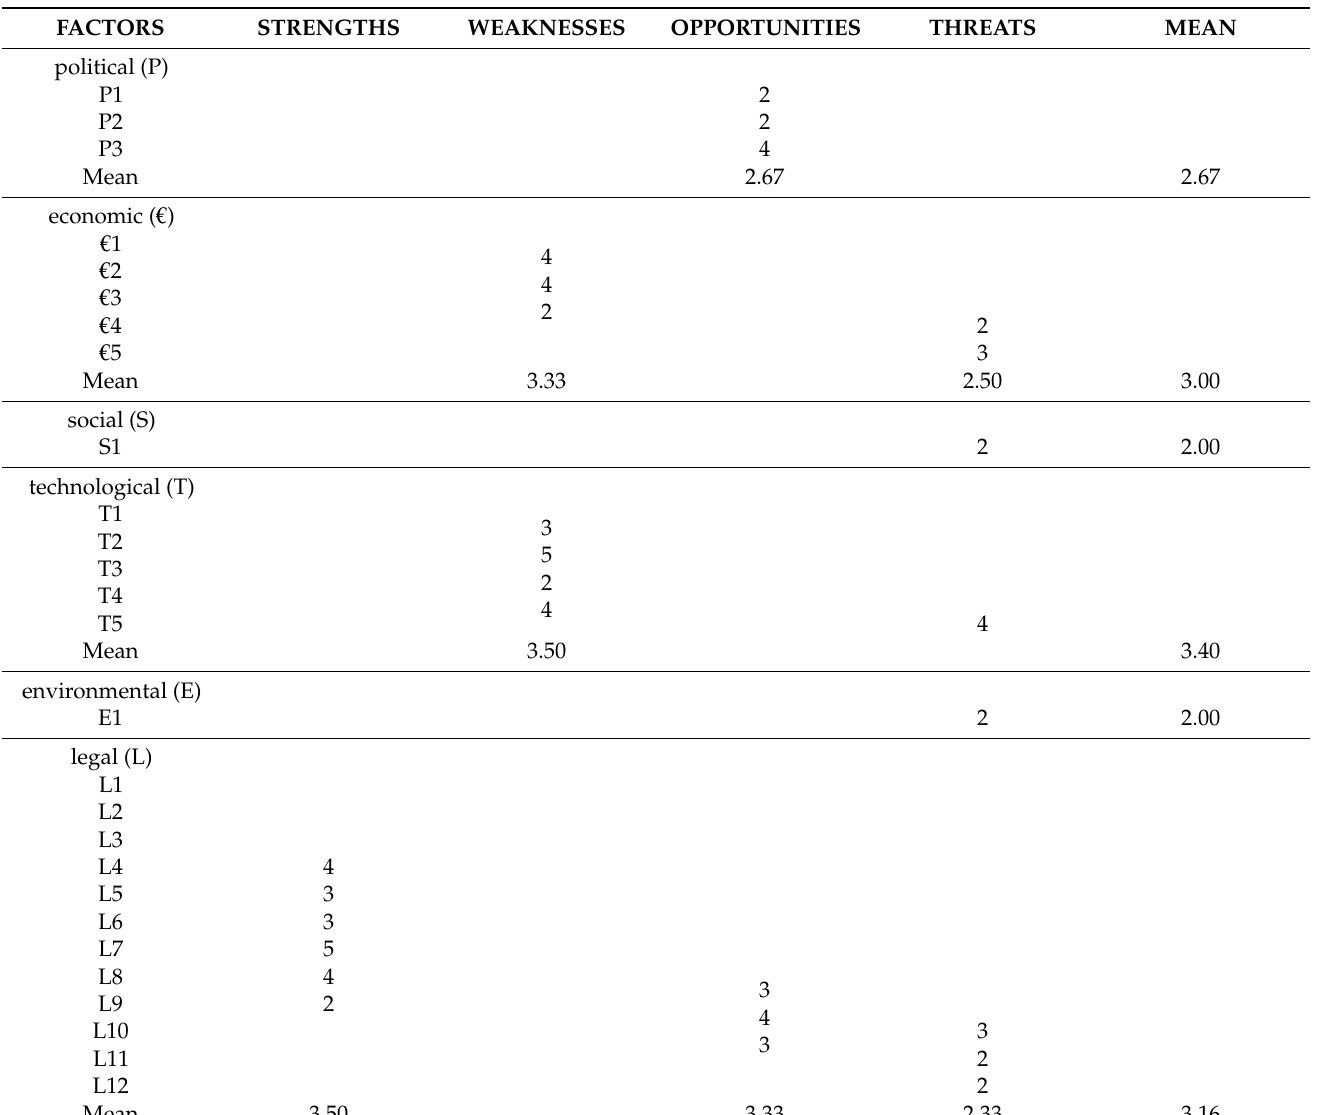
Table 8. SWOT analysis for industrial waste management according to PESTEL analysis for par- ticular factors with assessment of the impact force (a scale from 1 to 5, where 1—small impact, 5—large